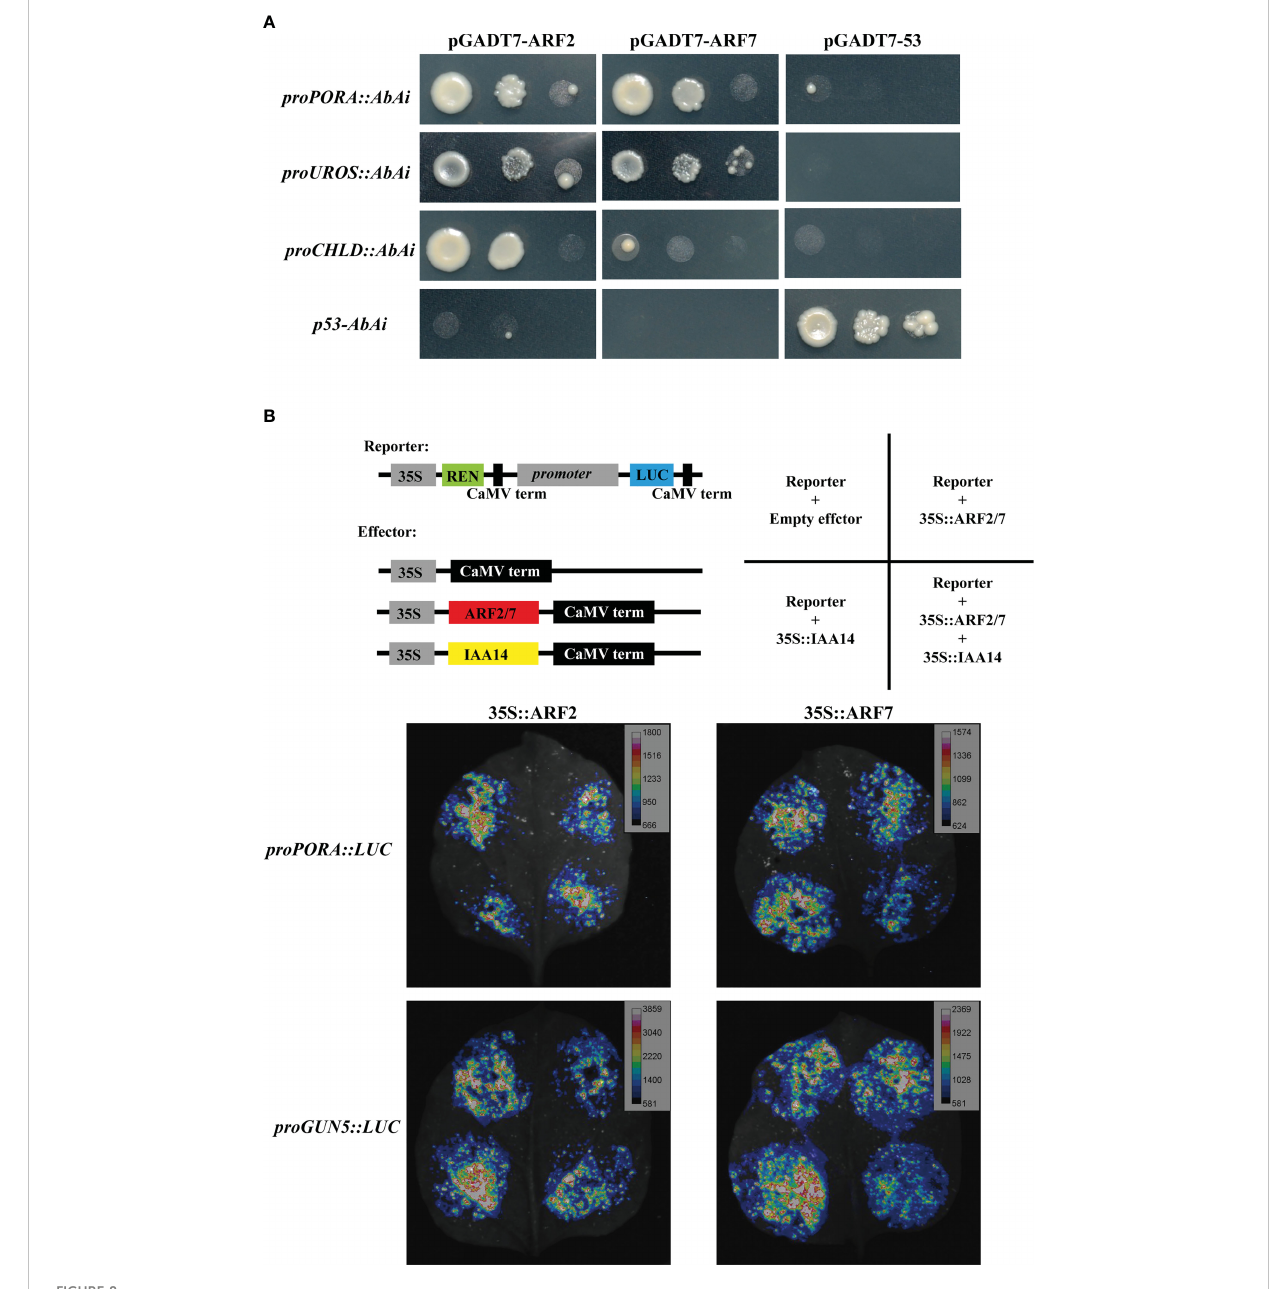
FIGURE 8 Interaction between ARFs and chlorophyll biosynthesis genes. (A) Yeast-one-hybrid assay showing ARF2 and ARF7 bind to the promoter of PORA , UROS and CHLD ; (B) proPORA and proGUN5 were suppressed by ARF2 and ARF7 cooperated with IAA14 in luciferase reporter